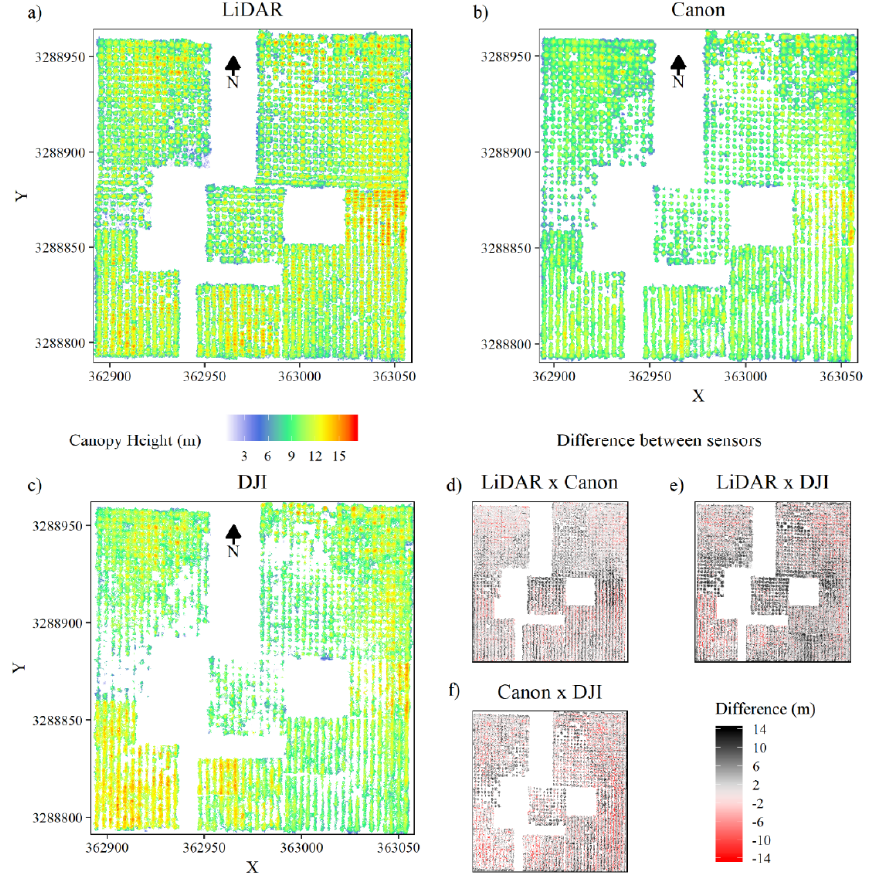
Figure 4. Canopy height models ( a – c ) and canopy height model (CHM) differences between sensors ( d – f ).